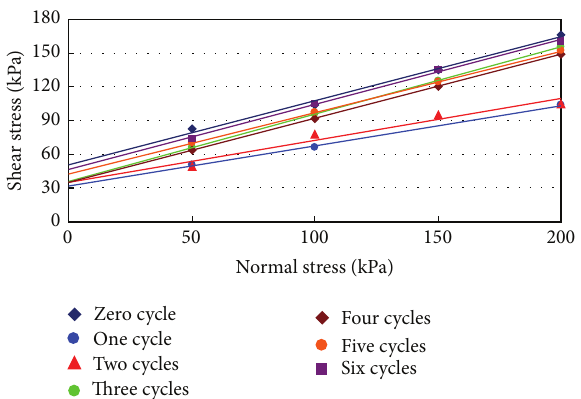
Figure 8: The strength envelope of the slip zone soil under different numbers of cycle.